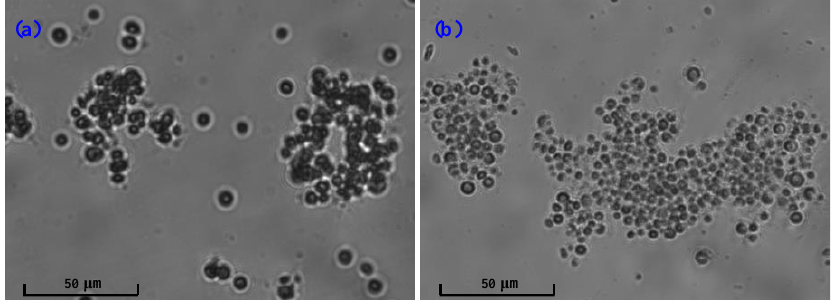
Figure 5. Microscopic morphology of the microalgae in the MPBR ( a ) before and ( b ) after decay. For the MPBR system, particle size is very important for membrane fouling